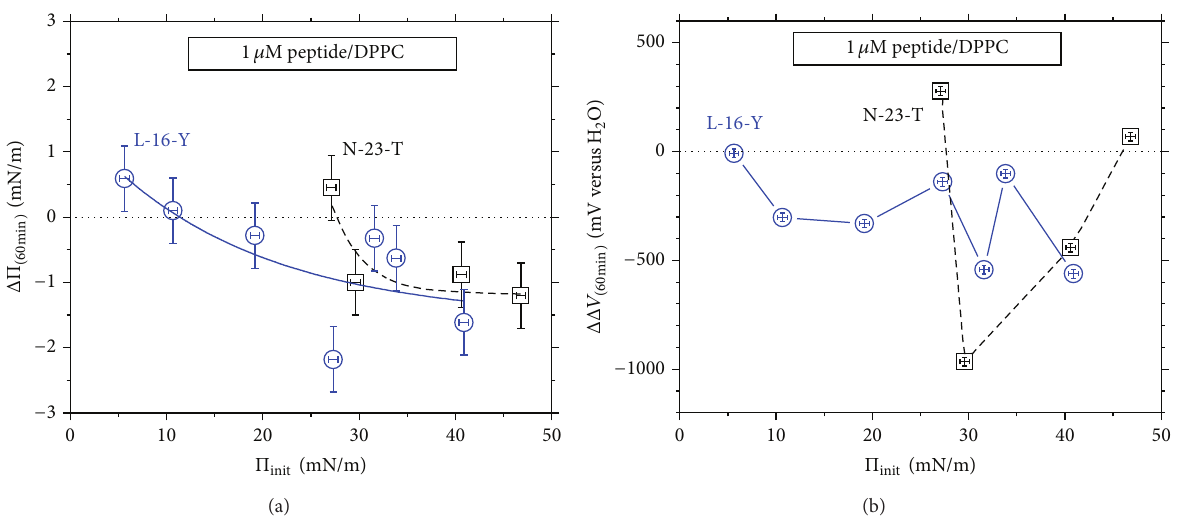
Figure 6: Effects of penetration of L-16-Y and N-23-T peptides to DPPC monolayer under stationary diffusion conditions on (a) surface pressure (Π) and (b) electric surface potential ( Δ𝑉 ); the ΔΠ and the ΔΔ𝑉 effects measured after 60min. contacts are plotted as a function of density of the pure phospholipid monolayer characterized by the initial surface pressure, Π and for Δ𝑉 is ± 20 mV, at maximum. The peptides’ concentration is 1 𝜇 M.